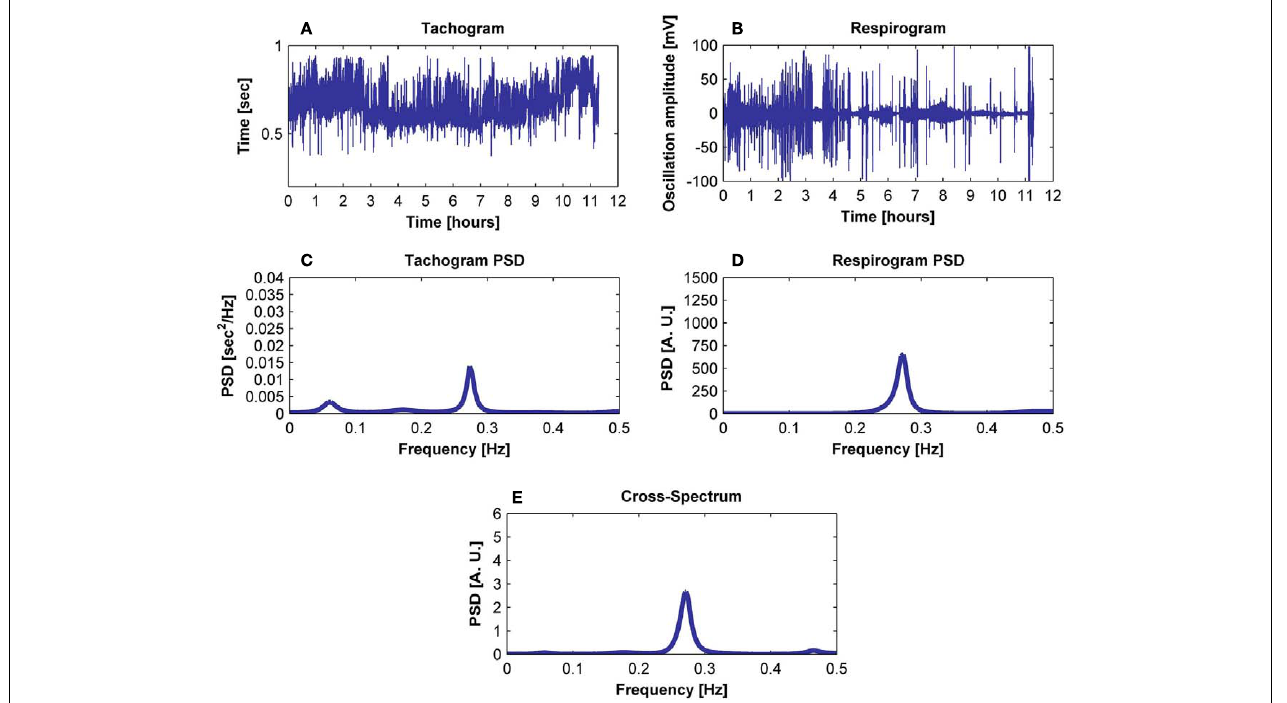
FIGURE 1 | Exemplification of the procedure followed to obtain (E) the cross-spectrum of (A) the tachogram and (B) the respirogram of a subject using (C) the tachogram spectrum and (D) the respirogram spectrum.